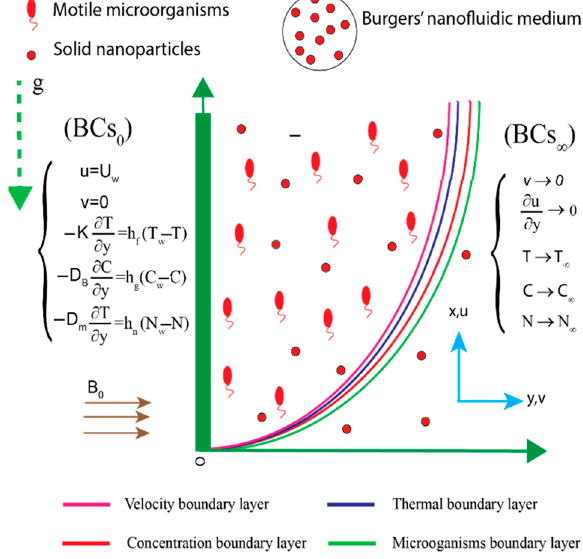
Figure 2. Flow chart for a current problem.